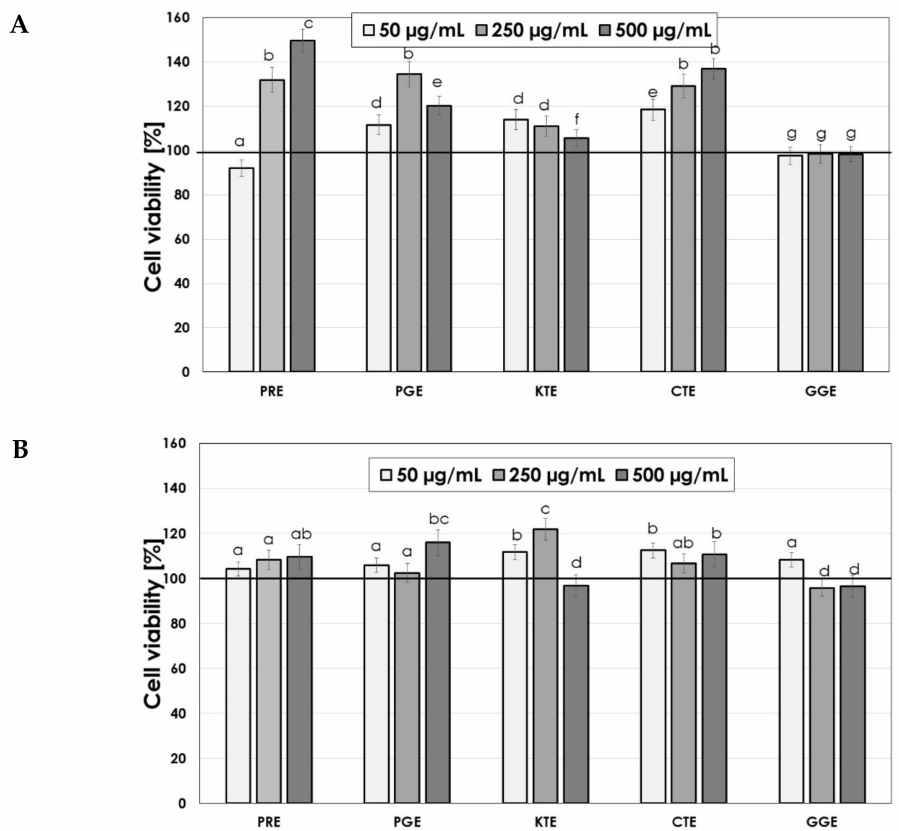
Figure 7. The effect of increasing concentrations of PRE, PGE, KTE, CTE and GGE extracts on Neutral Red Dye uptake in cultured fibroblasts ( A ) and keratinocytes ( B ) after 24 h of exposure. Data are the mean ± SD of three independent experiments each consisting of four replicates per test